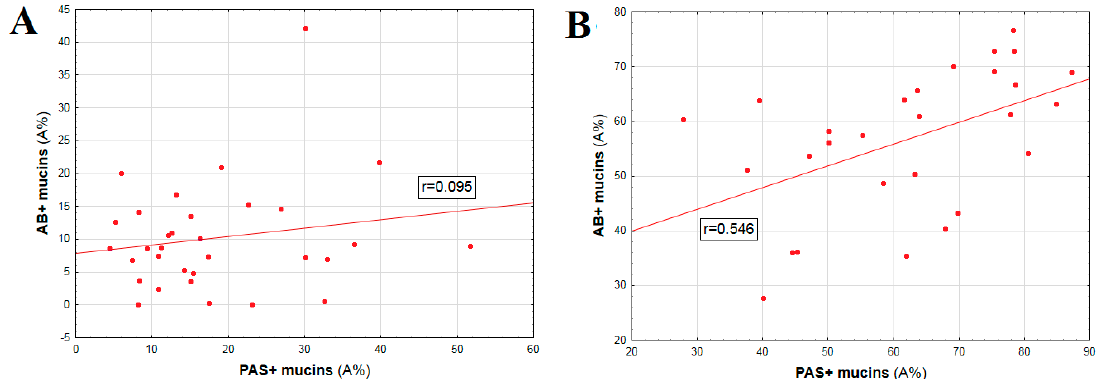
Figure 4. Correlation between mutual expression of PAS + and AB + polysaccharides in colorectal cancer (p > 0.05) ( A ) and unaltered colorectal tissue (control) ( p < 0.05) ( B ); r —Spearman’s rank correlation coefficient.